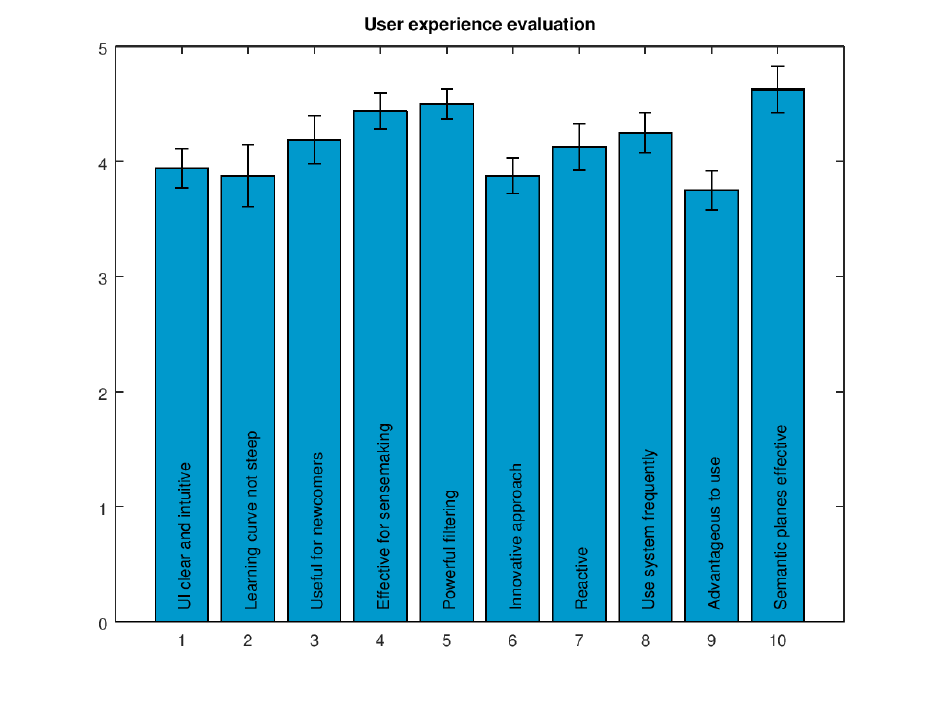
Figure 17. Mean and standard error of the mean (SEM) of the results of the questionnaire